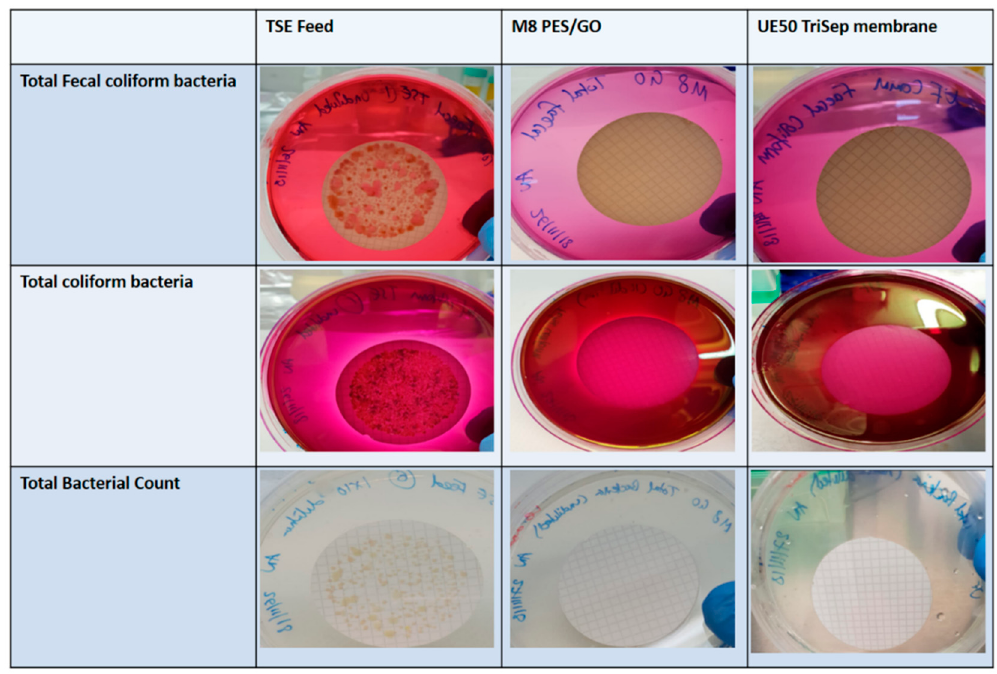
Figure 16. Photo of images of agar plates containing cellulose discs after filtration of TSE (treated sewage effluent) Feed and TSE permeate of M8 PES/GO membrane and commercial TriSep membrane.